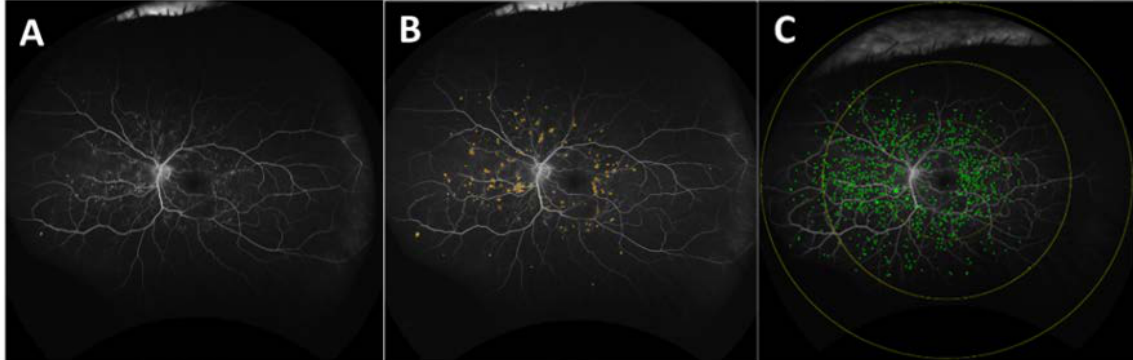
Figure 3. ( A ) Dewarped late-phase UWFA scan; ( B ) dewarped late-phase UWFA scan with overlay (yellow) indicating the area occupied by leakage; ( C ) dewarped early phase UWFA scan with overlay (green) indicating individual MAs in 3 mm (macular), 6 mm, and 9 mm zones (yellow circles). UWFA: ultra-widefield fluorescein angiography .